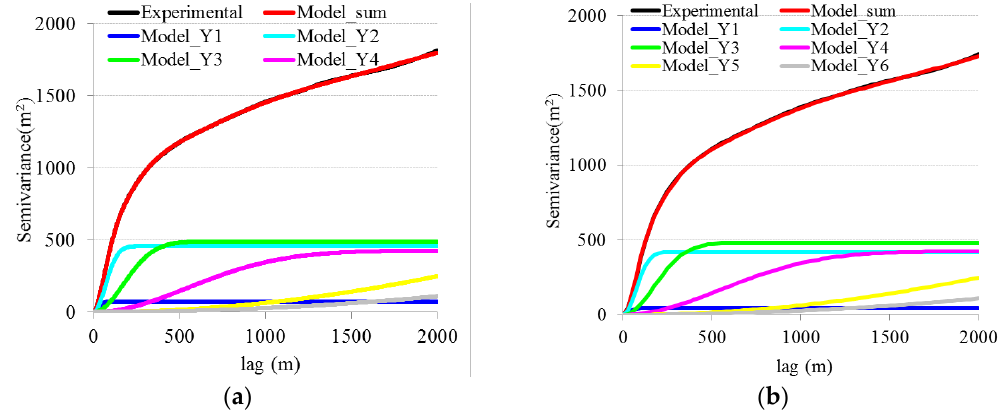
Figure 4. Modeling result for semi-variograms based on the theory of effect of upscaling on semi-variograms and Filter bank. ( a ) DEM2.5; ( b ) DEM25. Table 3. Parameters of ISM for DEMs based on the theory of effect of upscaling on